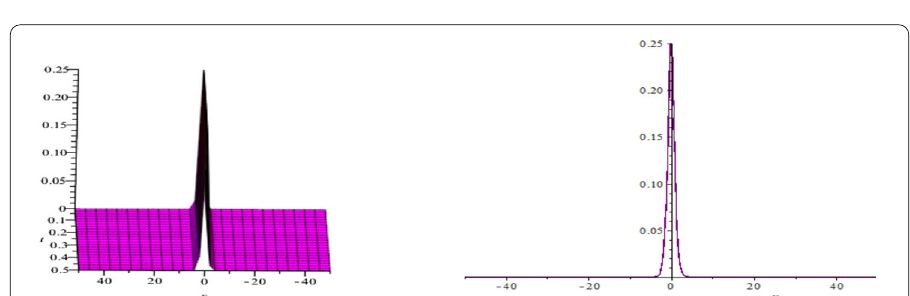
Figure 3 Modulus plot of solution (5.26) which is a cuspon